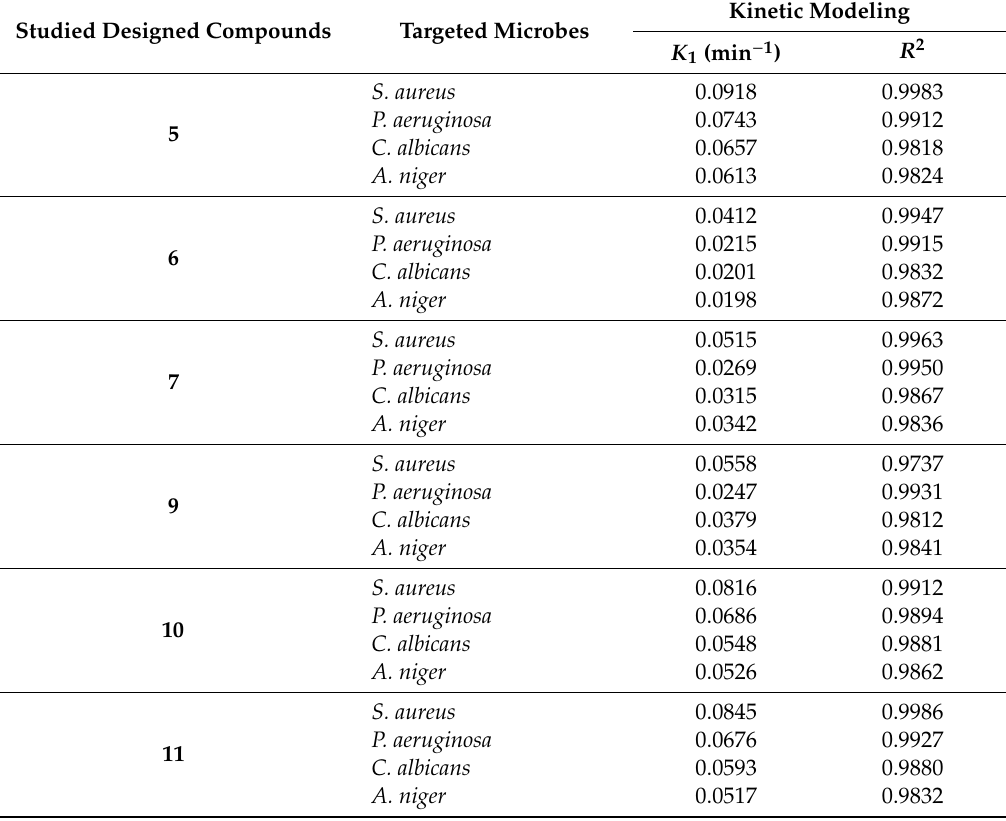
Table 4. The killing rate of targeted microbes by 2.5 mg / mL of the designed compounds using Pseudo-first-order kinetic